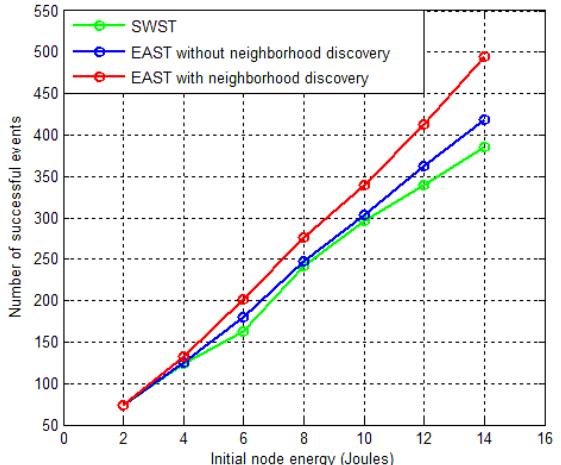
Fig. 7. Effect of the initial energy of each node over the number of successful events for SWST, EAST without neighborhood discovery and EAST with neighborhood discovery algorithms